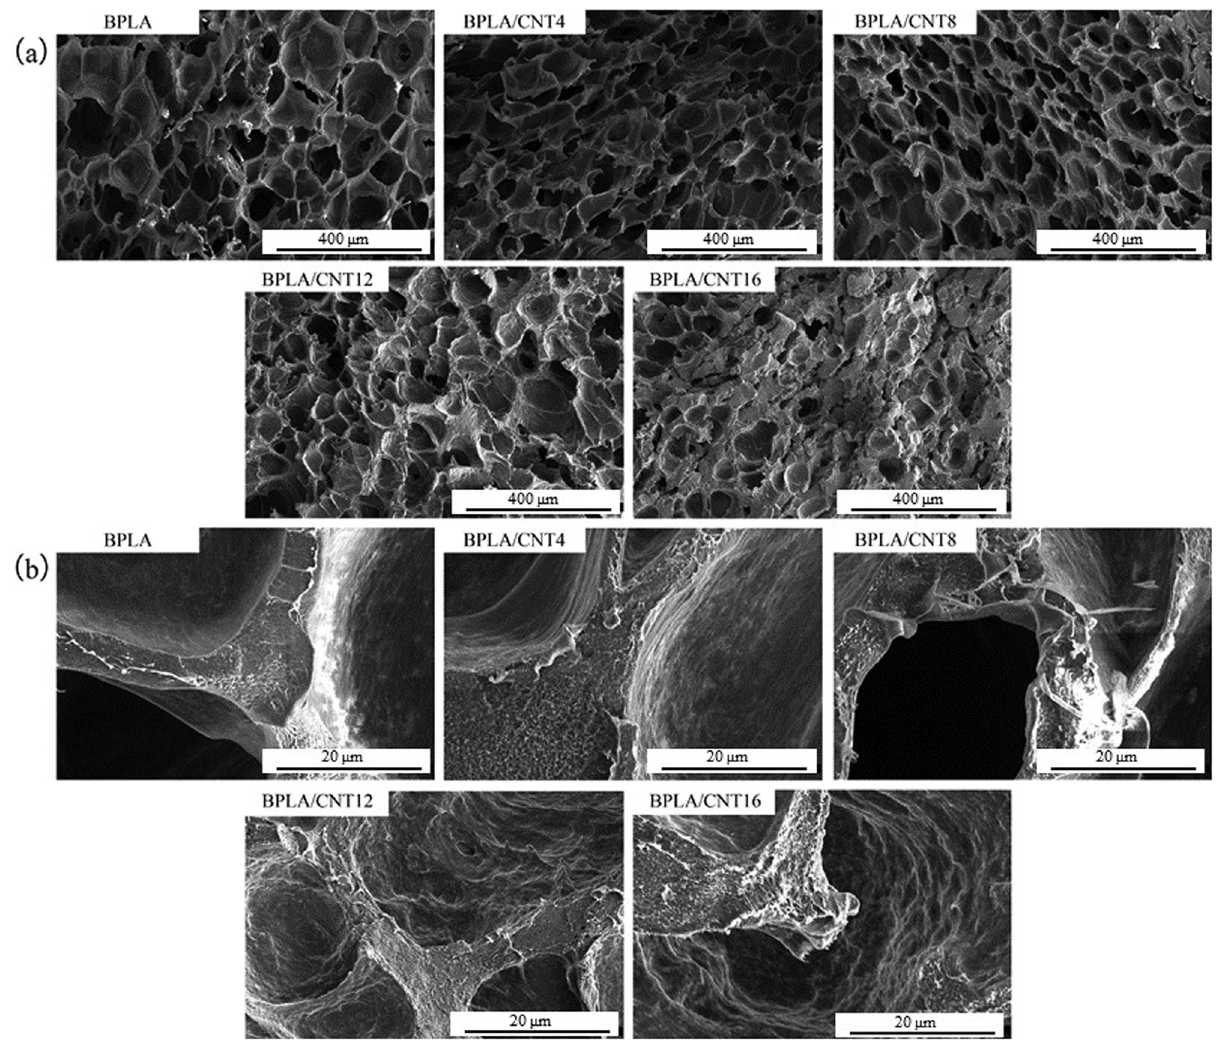
Figure 6: ( a ) Cellular structure of BPLA/CNT foams; ( b ) cellular wall of BPLA/CNT foams.